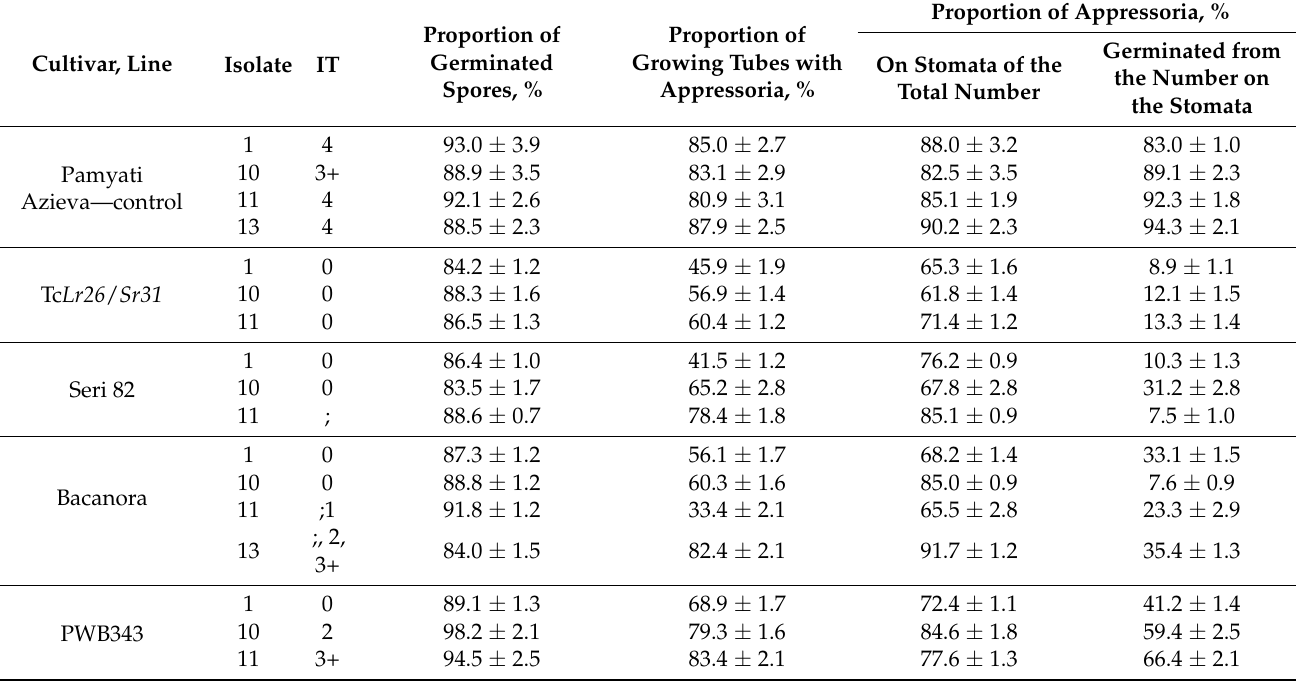
Table 4. Results of the development of infection structures of P. graminis f. sp. tritici on the surfaces of common wheat samples with Sr31